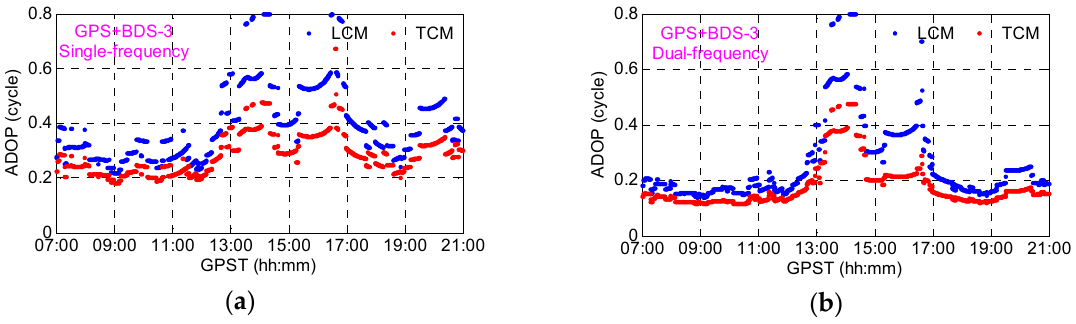
Figure 10. Ambiguity dilution of precision (ADOP) for GPS/BDS-3 single-frequency ( a ) and dual-frequency ( b ) solutions with 10 ◦ elevation cut-off angle.